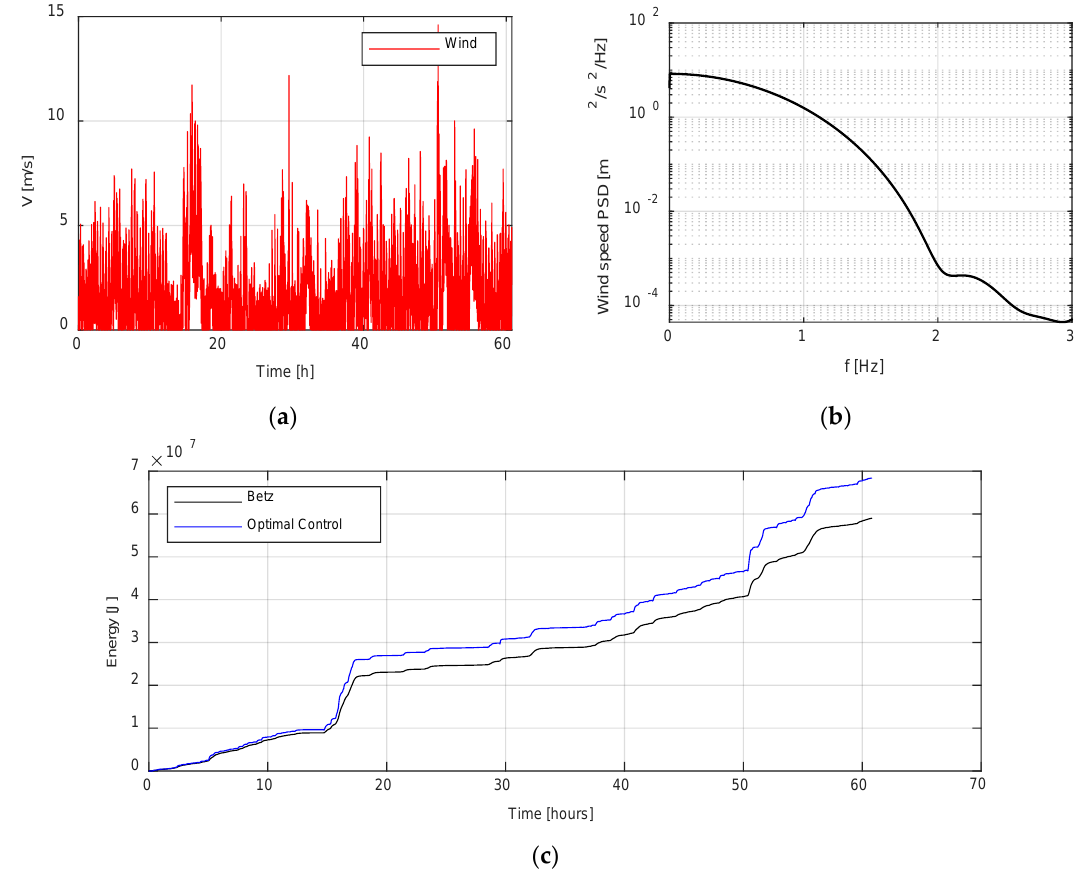
Figure 8. Comparison between the OCBM optimal control and Steady wind turbine for random wind: ( a ) the trend of the wind speed; ( b ) the wind speed power spectral density (PSD); ( c ) the energy storage.